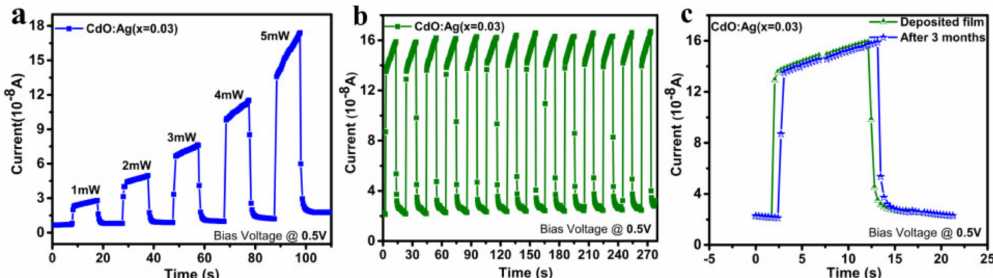
Figure 9. ( a ) Photocurrent kinetics with respect to different light intensities from 1 mW/cm 2 to 5 mW/cm 2 . ( b ) Repeatability and ( c ) stability at 5 mW/cm 2 for the optimum 3 at.% Ag-doped CdO